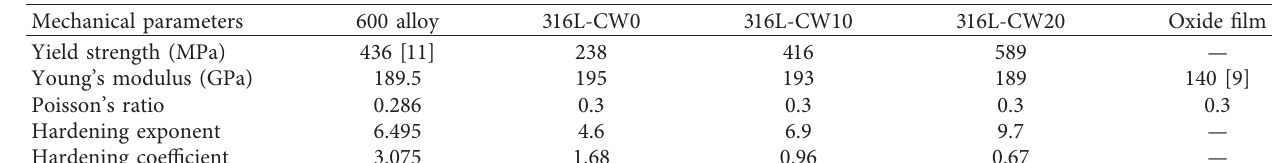
Table 1: Mechanical parameters of materials.